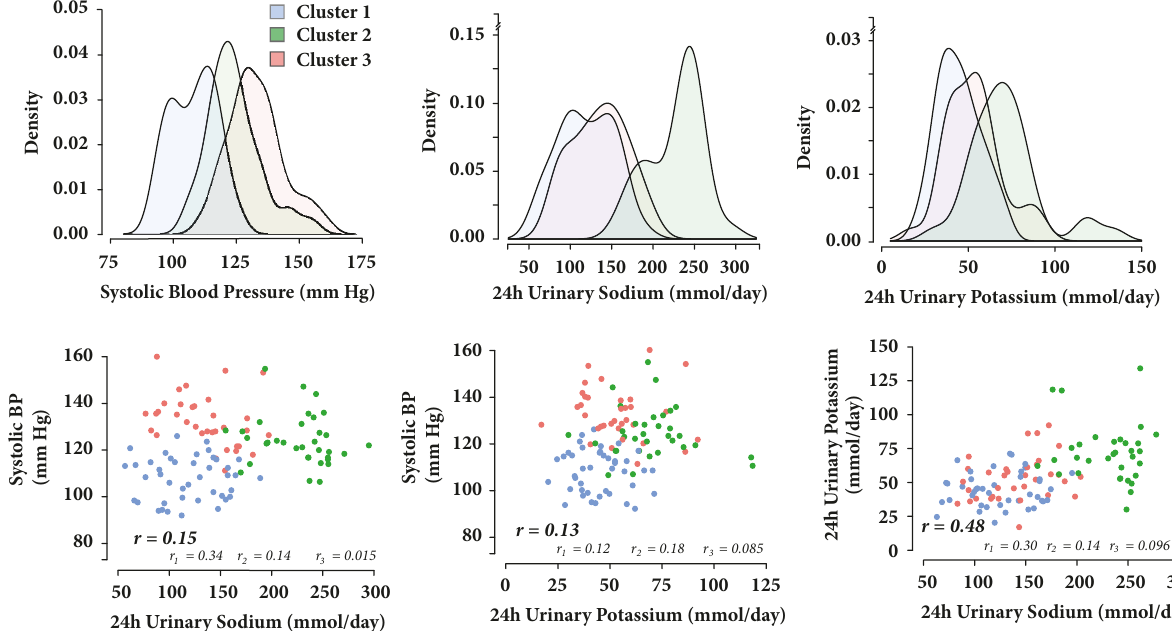
Figure 1: Density of systolic blood pressure (a), 24-hour urinary sodium (b), and potassium (c) excretion by cluster. Correlations between 24-hour urinary sodium and office systolic blood pressure (d) and 24-hour urinary potassium excretion and office systolic blood pressure (e), and the correlation between 24-hour urinary excretion of sodium and potassium (f). 𝑟 : correlation